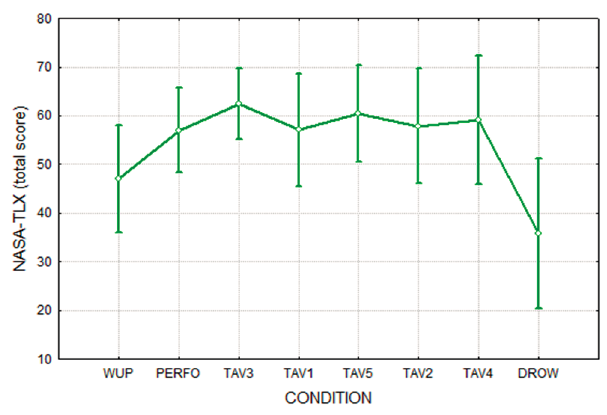
Figure 4. NASA-TLX total score related to the different experimental